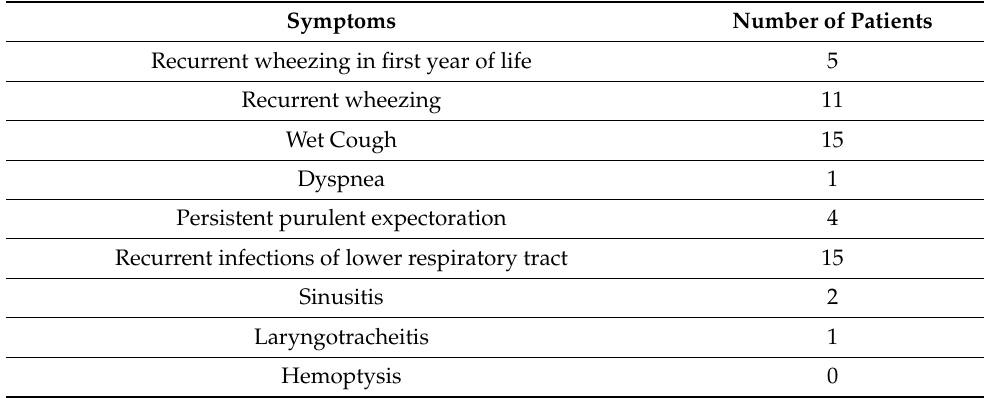
Table 2. Clinical patient’s